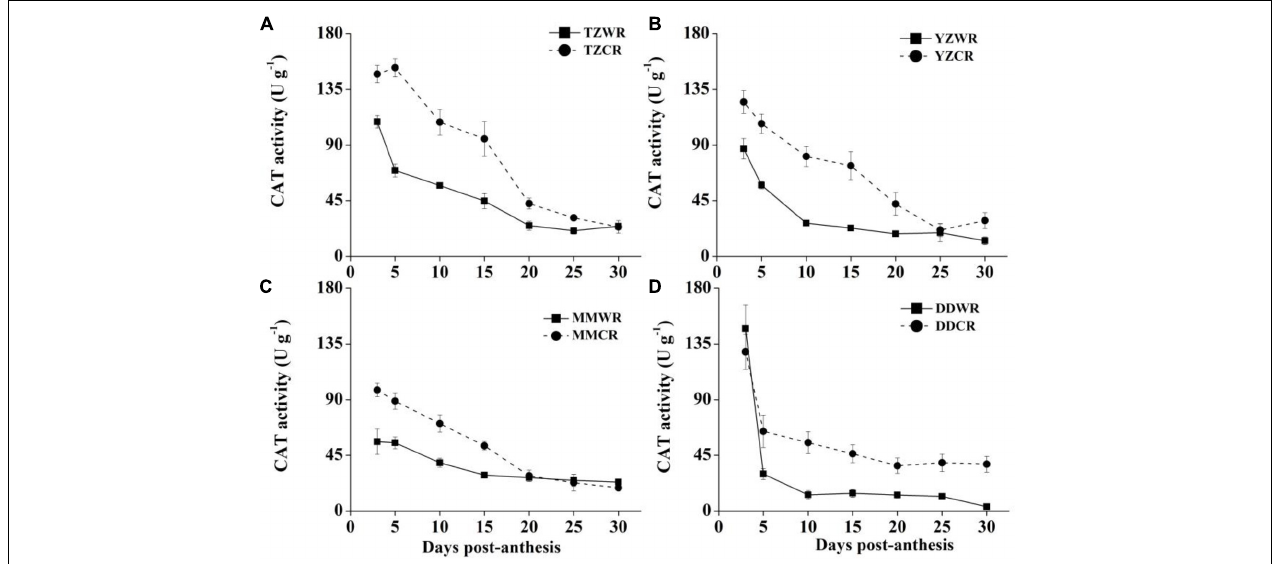
FIGURE 5 | Changes in activities of CAT in weedy rice and cultivated rice. (A) Weedy and cultivated rice from Taizhou; (B) weedy and cultivated rice from Yangzhou; (C) weedy and cultivated rice from Maoming; (D) weedy and cultivated rice from Dandong. TZWR, weedy rice from Taizhou; TZCR, cultivated rice from Taizhou; YZWR, weedy rice from Yangzhou; YZCR, cultivated rice from Yangzhou; MMWR, weedy rice from Maoming; MMCR, cultivated rice from Maoming; DDWR, weedy rice from Dandong; DDCR, cultivated rice from Dandong. Solid line represents weedy rice and dash line represents cultivated rice. The data are presented as mean ± SE ( n = 3).